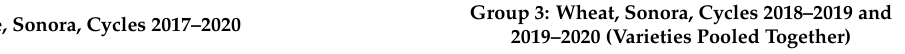
Table 9. Means comparisons of experiments conducted in Sonora, Mexico from 2017–2020 with maize (Group 2) and from 2018–2019 and 2019–2020 with wheat (Group 3) to test the effectiveness of partially substituting synthetic fertilizers by